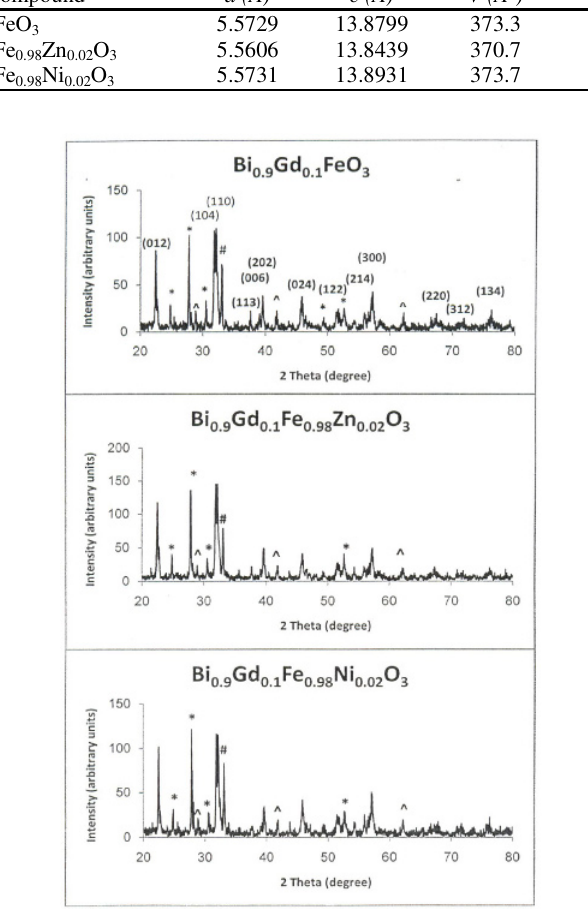
Fig. 2. The XRD of the Gd-doped samples